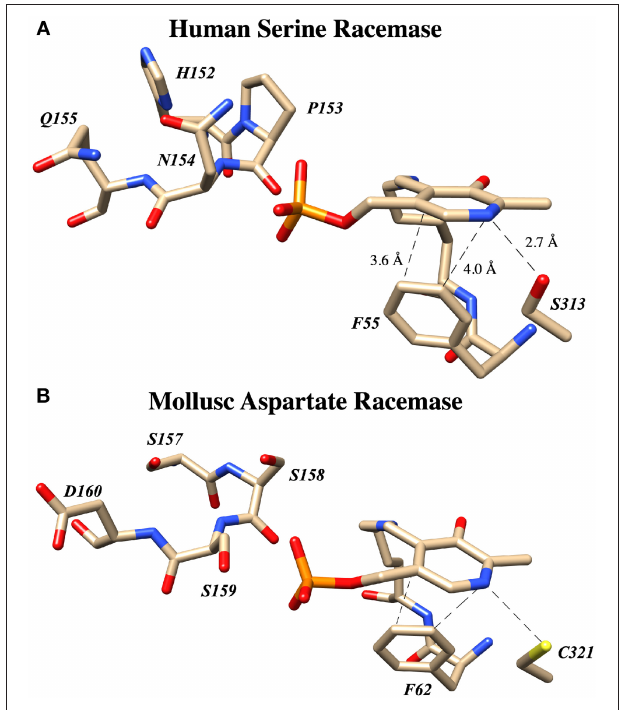
FIGURE 10 | The “Triple serine loop” in hSR and Anadara broughtonii (AbAR) is situated near the presumed locus of the external aldimine and the carbanionic intermediate derived therefrom. (A) Crystal structure of human serine racemase (3L6B) loop region containing H152, P153, N154, and Q155. (B) Corresponding region of aspartate racemase (5YBW) with residues S157, S158, S159,